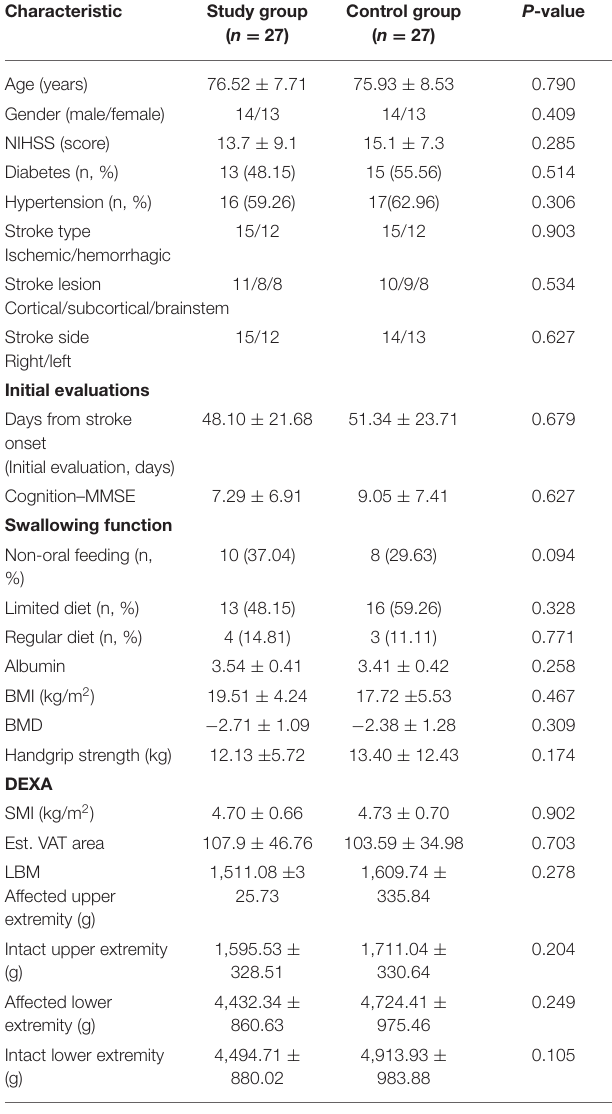
TABLE 1 | Demographic characteristics of patients in both